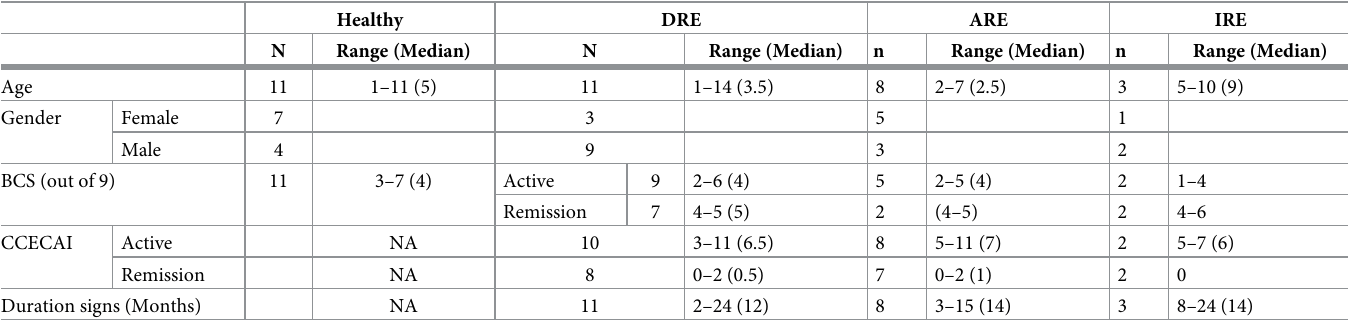
Table 1. Demographic data of study dogs.